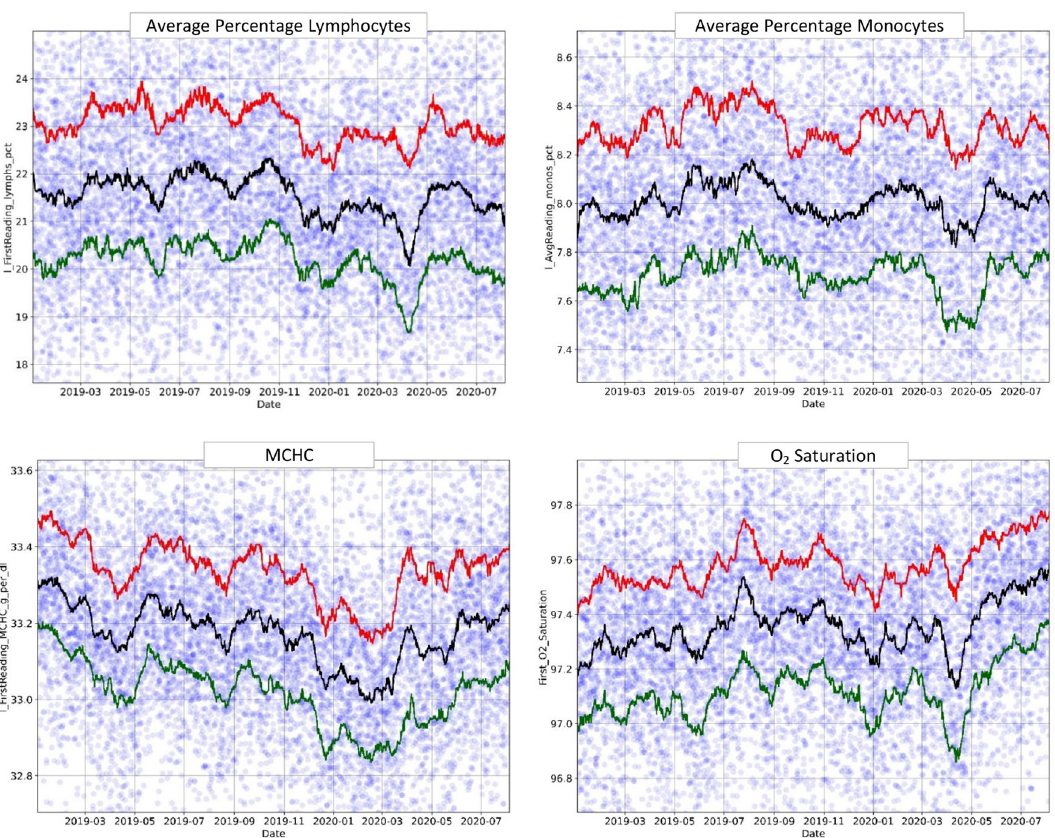
Figure 5. Decreasing trends: lymphocyte and monocyte percentages, MCHC, and O 2 saturation over time (January 2019–August 2020). The circles represent the original data averaged over 6-h intervals, and the lines- moving percentile curves for 25%, 50%, and